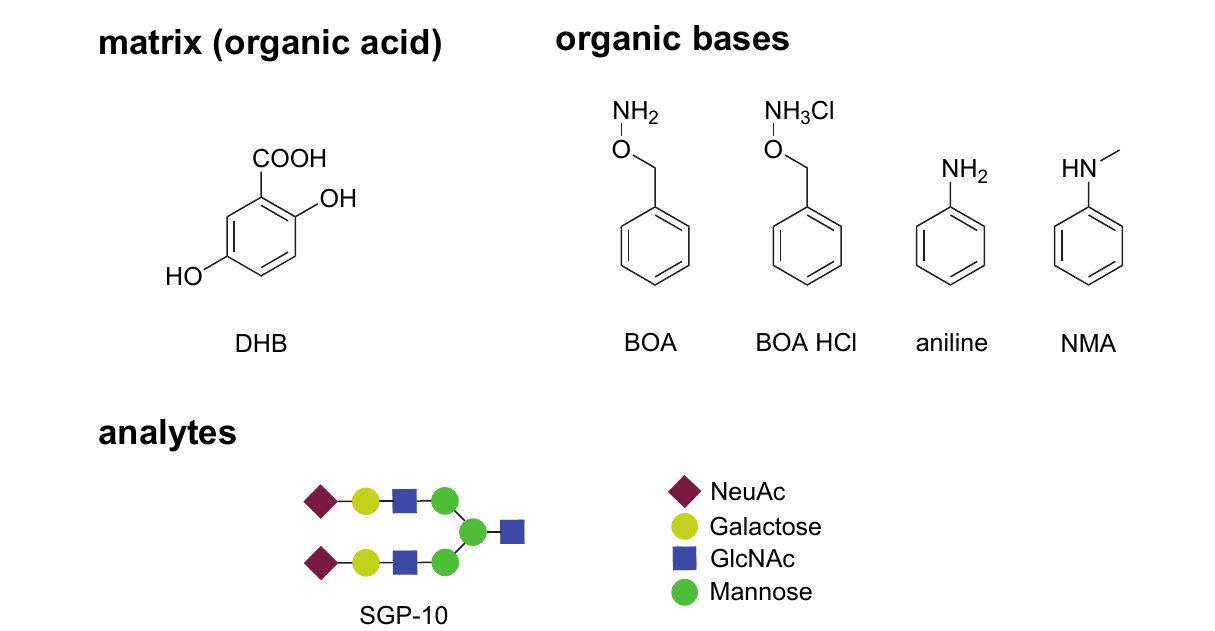
Figure 1. Chemical structure of the organic base and acid components for the solid ionic matrices used in this study, and a schematic diagram of the sequences and constituent monosaccharides of the ana- lyte. DHB: 2,5-Dihydroxybenzoic acid; BOA: O -benzylhydroxylamine; NMA: N -methylaniline, SGP-